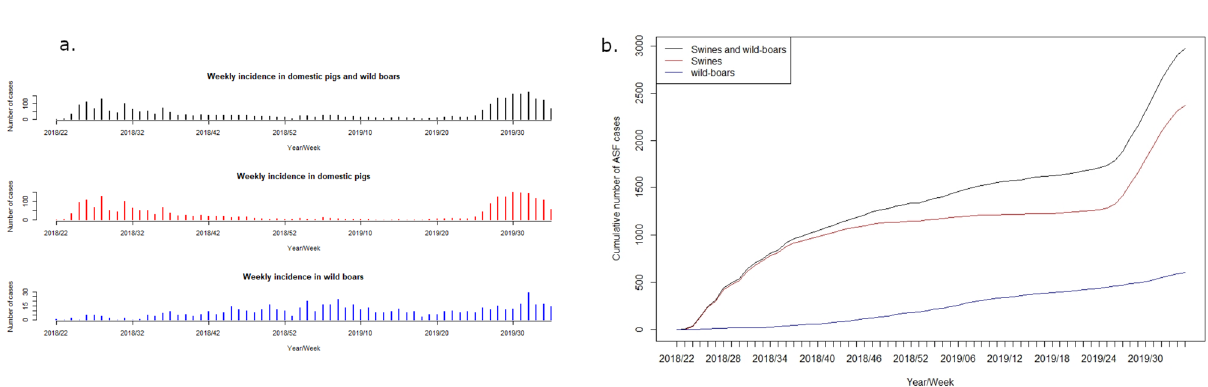
Figure 3. Temporal characteristics of the ASF epidemics in Romania (epidemiologic data): weekly incidence in wild boars, domestic pigs and total population ( a ), and cumulative incidence throughout the period ( b